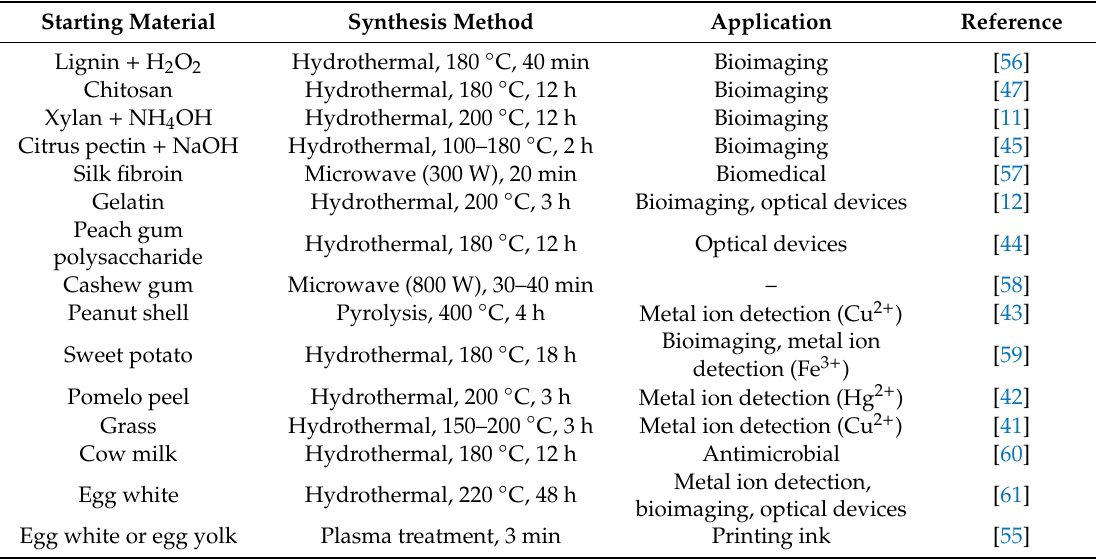
Table 3. Natural polymer-derived CDs, preparation methods, and